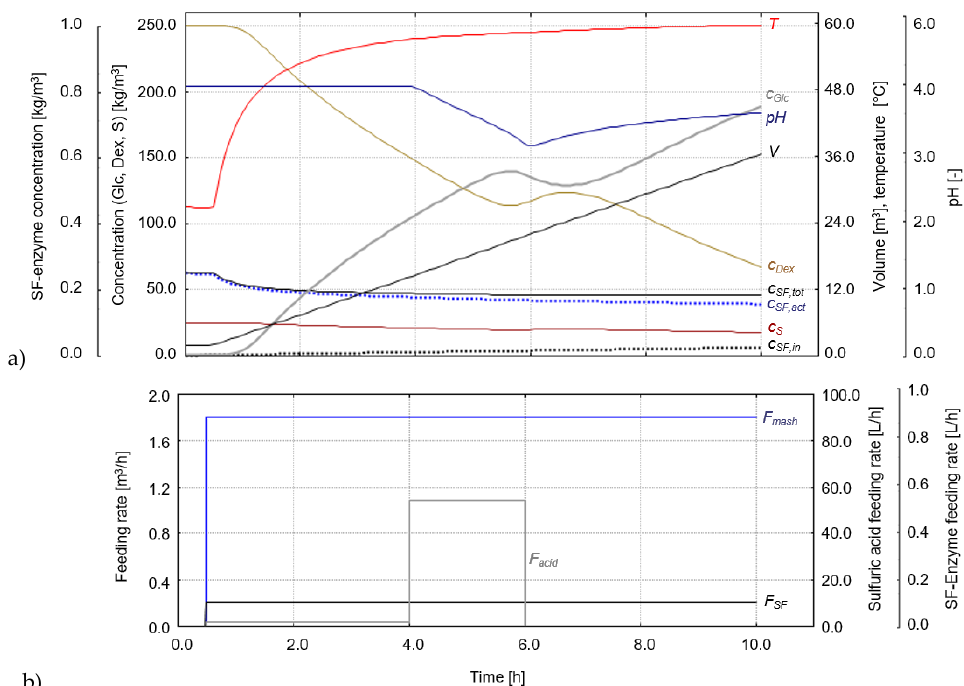
Figure 4. Hydrolysis model simulation showing concentrations for starch ( c S ), dextrins ( c Dex ), glucose ( c Glc ), and total SF-enzyme formed by active and inactive SF-enzyme ( c SF,tot = c SF,act + c SF,in ) as well as volume ( V ), temperature ( T ) and pH (Figure 4a). The operator’s action is shown in Figure 4b with start and adjustment of feed rates for mash, SF-enzyme and sulfuric acid ( F mash , F acid , F SF ). After 1 h, feeding starts at a rate of 1.8 m 3 ·h − 1 (feed temperature: 60 °C). Feeding solution has the same concentration for starch, dextrins and glucose as shown for the initial values. Enzyme solution is added at 1.1 L·h − 1 and acid at 1.98 L·h − 1 . Acid feed is stopped at 6 h.